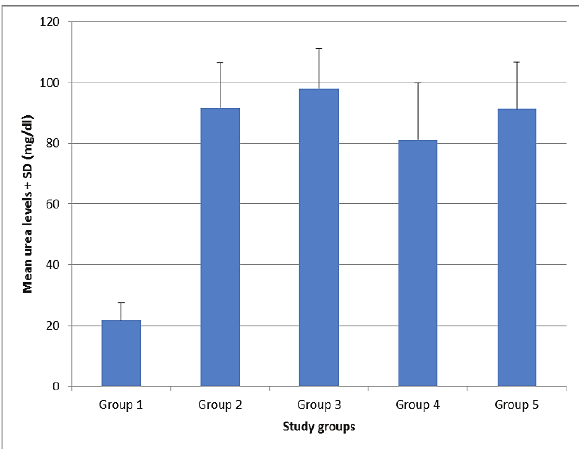
Fig- A: Mean urea levels of five study groups at 24 th day